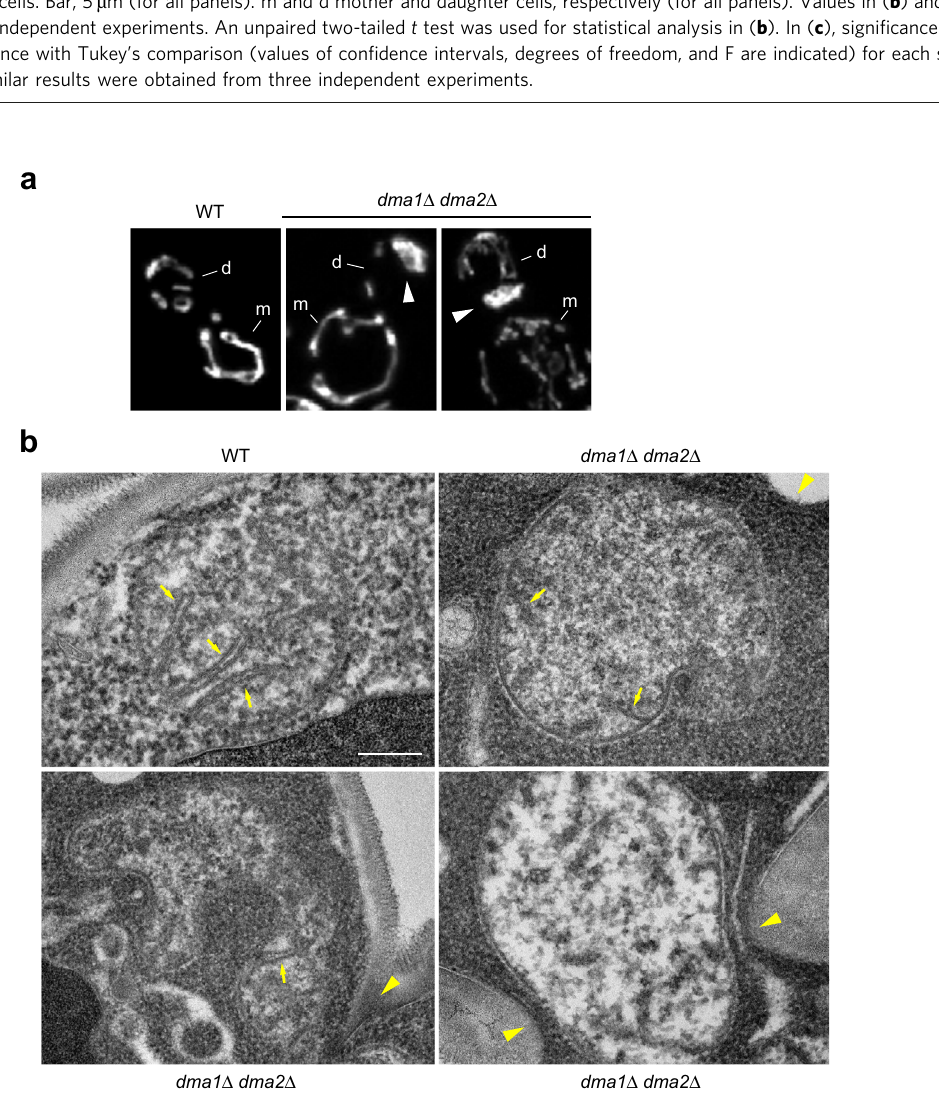
Fig. 4 Dma1 and Dma2 are required for the maintenance of mitochondria morphology. a YTK5334 ( Mt-GFP ) and YTK5341 ( Mt-GFP dma1 Δ dma2 Δ ) cells were grown to log phase in synthetic complete medium, fi xed, and observed under a fl uorescence microscope. Optical sections were obtained using a structured-illumination microscopy system at an interval of 0.2 µ m, deconvoluted, and reconstructed into a 3D image. m and d, mother cell and daughter cell, respectively. Arrowhead, stacked mitochondria. b W303-1a (WT) and YTK5416 ( dma1 Δ dma2 Δ ) cells were grown to log phase in a synthetic complete medium and subjected to electron microscopy. 58 and 54 cells for WT and dma1 Δ dma2 Δ cells, respectively, were analyzed. Arrow, cristae. Arrowhead, bud neck. Bar, 200